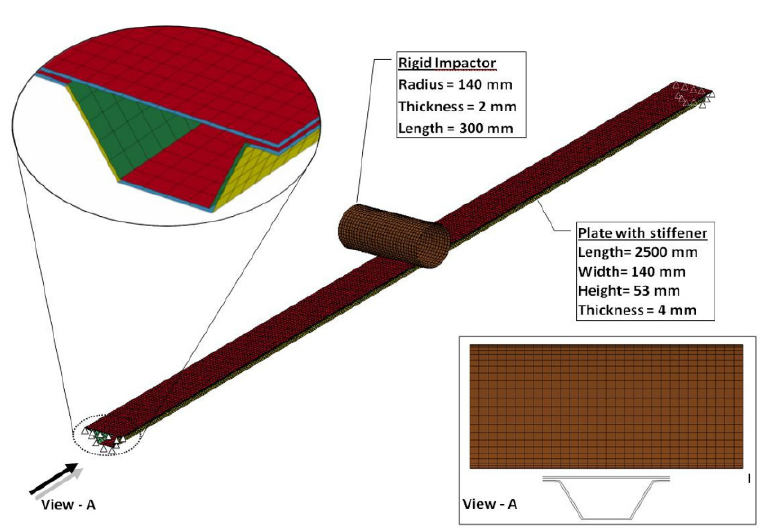
Figure 9. Composite stiffened plate; 12 plies in each sublaminates with stacking sequence of [ − 45/0/45/90]